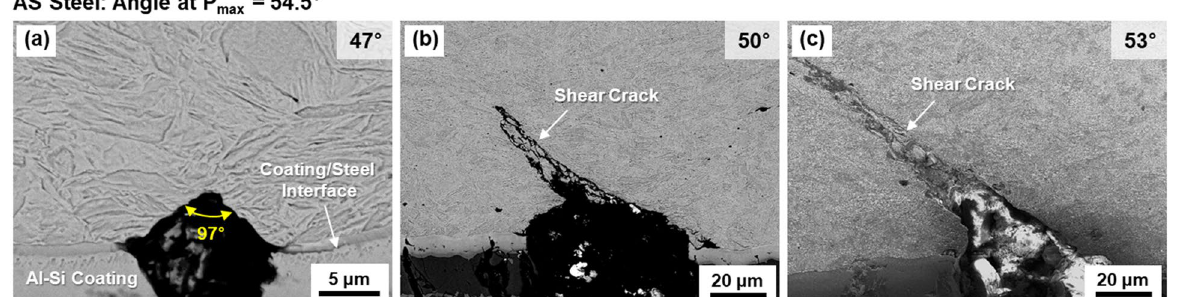
Figure 7. ( a – c ) SEM micrographs illustrating sequential V-cracking processes at various bending angles in the AS steel. The second bending stage (increase in number and size of V-cracks) does not occur as the shear crack initiated at the V-crack tip propagates rapidly without enlarging the V-crack or forming other